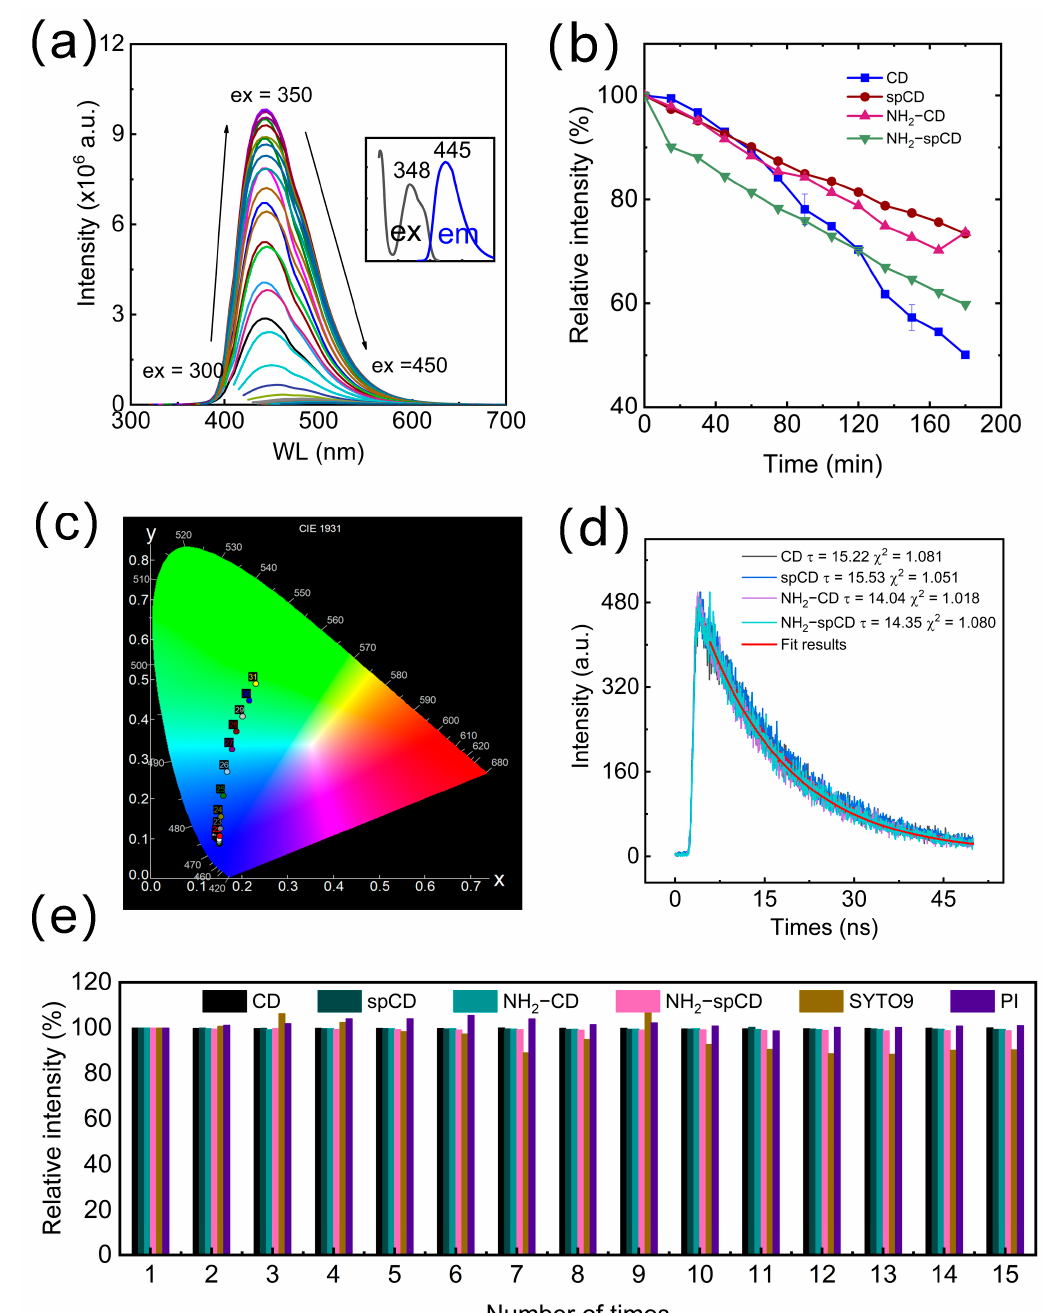
Figure 1. ( a ) Fluorescent emission map and ex–em spectrum of spCD, ( b ) Relative fluorescent intensity of CD, spCD, NH 2 –CD and NH 2 –spCD in a constant ultraviolet irradiation of 365 nm for 3 h, ( c ) CIE 1931 chromaticity chart of spCD at excitation of 300~450 nm (step = 5 nm), ( d ) Fluorescent lifetime of CD, spCD, NH 2 –CD and NH 2 –spCD, ( e ) Relative intensity changes of CD, spCD, NH 2 –CD, NH 2 –spCD and two dyes for a constant detection.